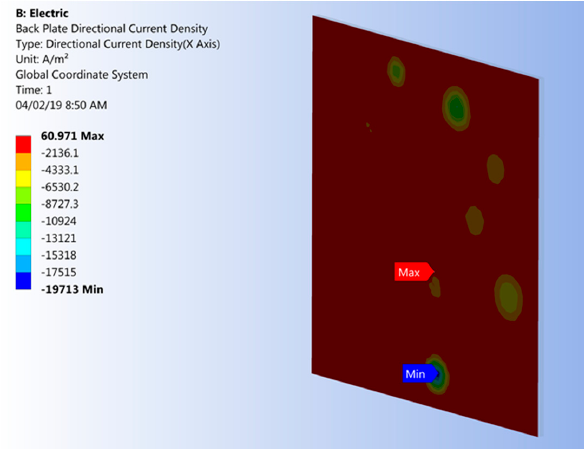
Figure 8. Example of simulated electrical current density on an electrical charge plate after achieving percolation conditions.